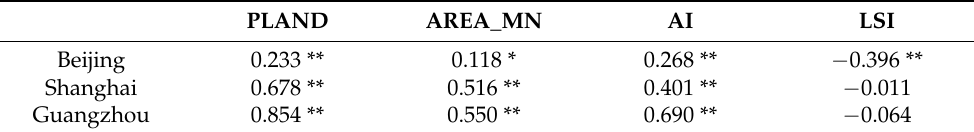
Table 5. Pearson correlation coefficients between the regional heat island intensity and spatial metrics.